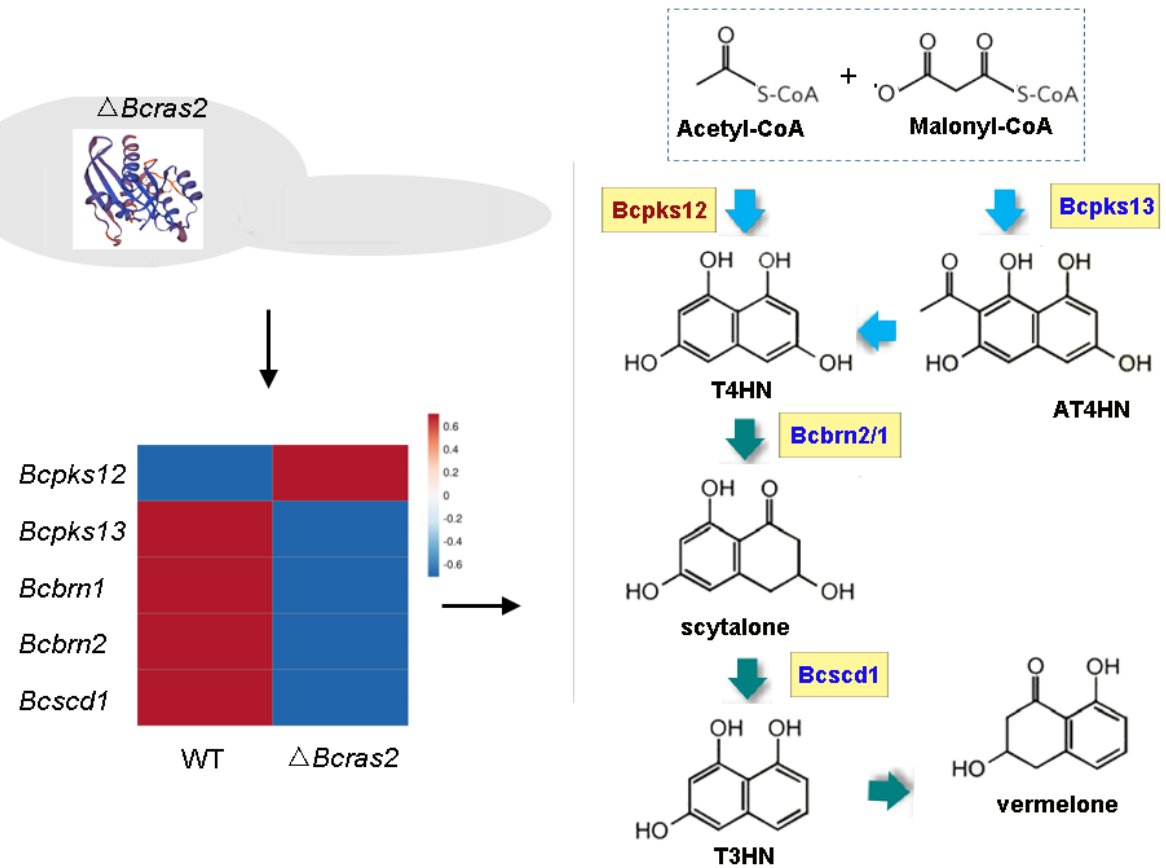
Figure 8. The melanin metabolic pathway is regulated by Bcras2. Bcpks12, Bcpks13: polyketide synthase. Bcbrn1, Bcbrn2: tetrahydroxynaphthalene reductases. Bcscd1: dehydratase. T4HN: 1,3,6,8-tetrahydroxynaphthalene. AT4HN: 2-acetyl-1,3,6,8-tetrahydroxynaphthalene. T3HN: 1,3,8-trihydroxynaphthalene. Right panel, red: up-regulated genes, blue: down-regulated genes.